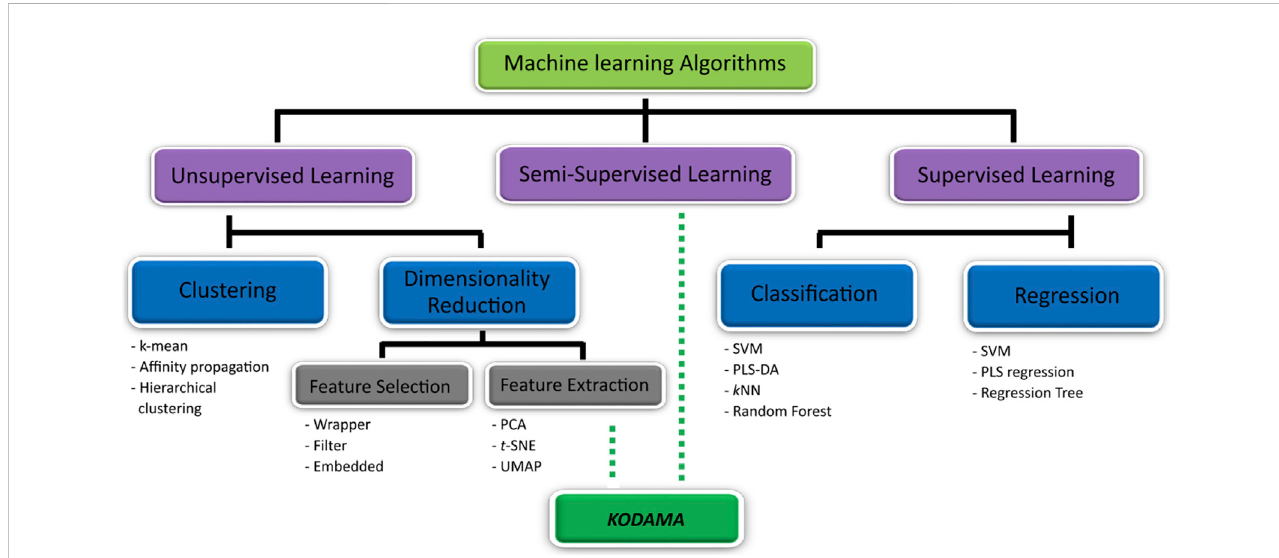
FIGURE 1 KODAMA on machine learning algorithm ’ s map. The machine learning algorithm can be categorized in unsupervised (i.e., clustering and dimensionality reduction method) and supervised learning. KODAMA is one of unsupervised learning methods used for dimensionality reduction. Optionally, if supervised information is used to lead the process of discovery of new patterns, KODAMA can be classi fi ed as